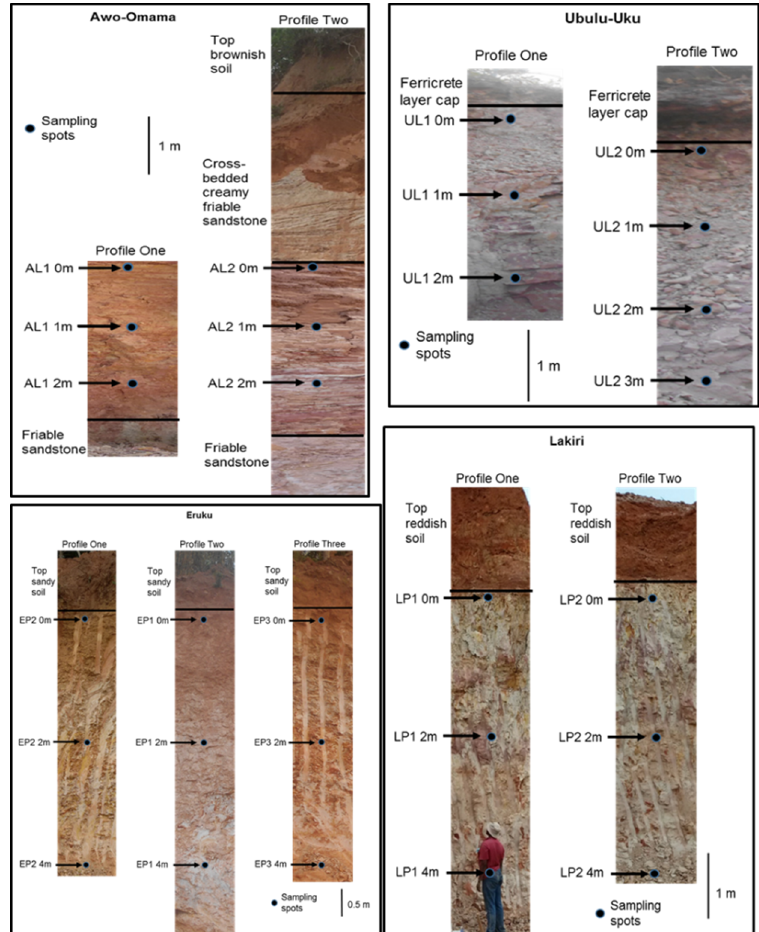
Figure 2. Vertical profiles showing sampling depths and lithologic units of the studied kaolin deposits (after [12]).